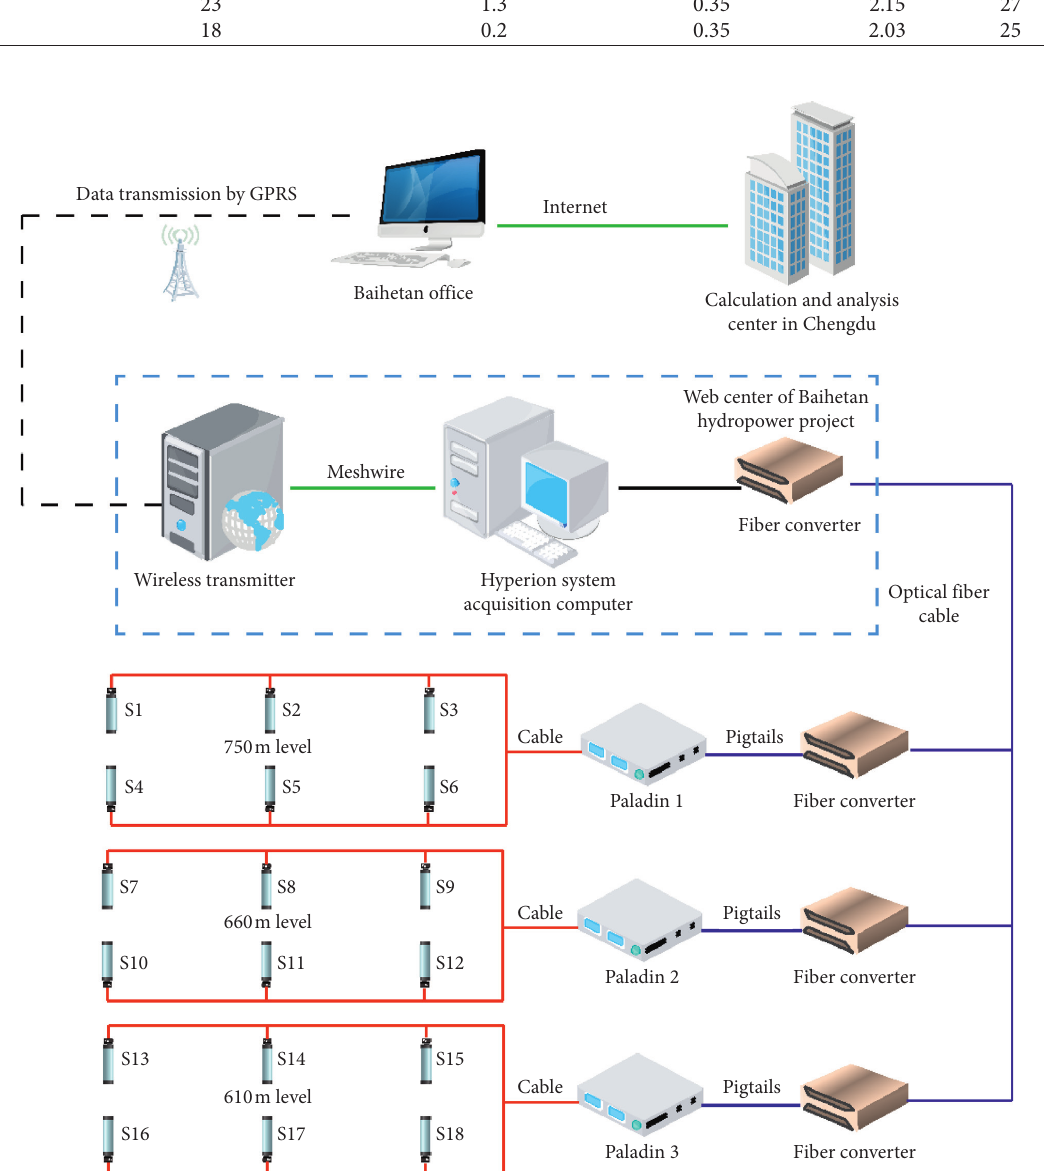
Figure 4: Network topology of the MS monitoring